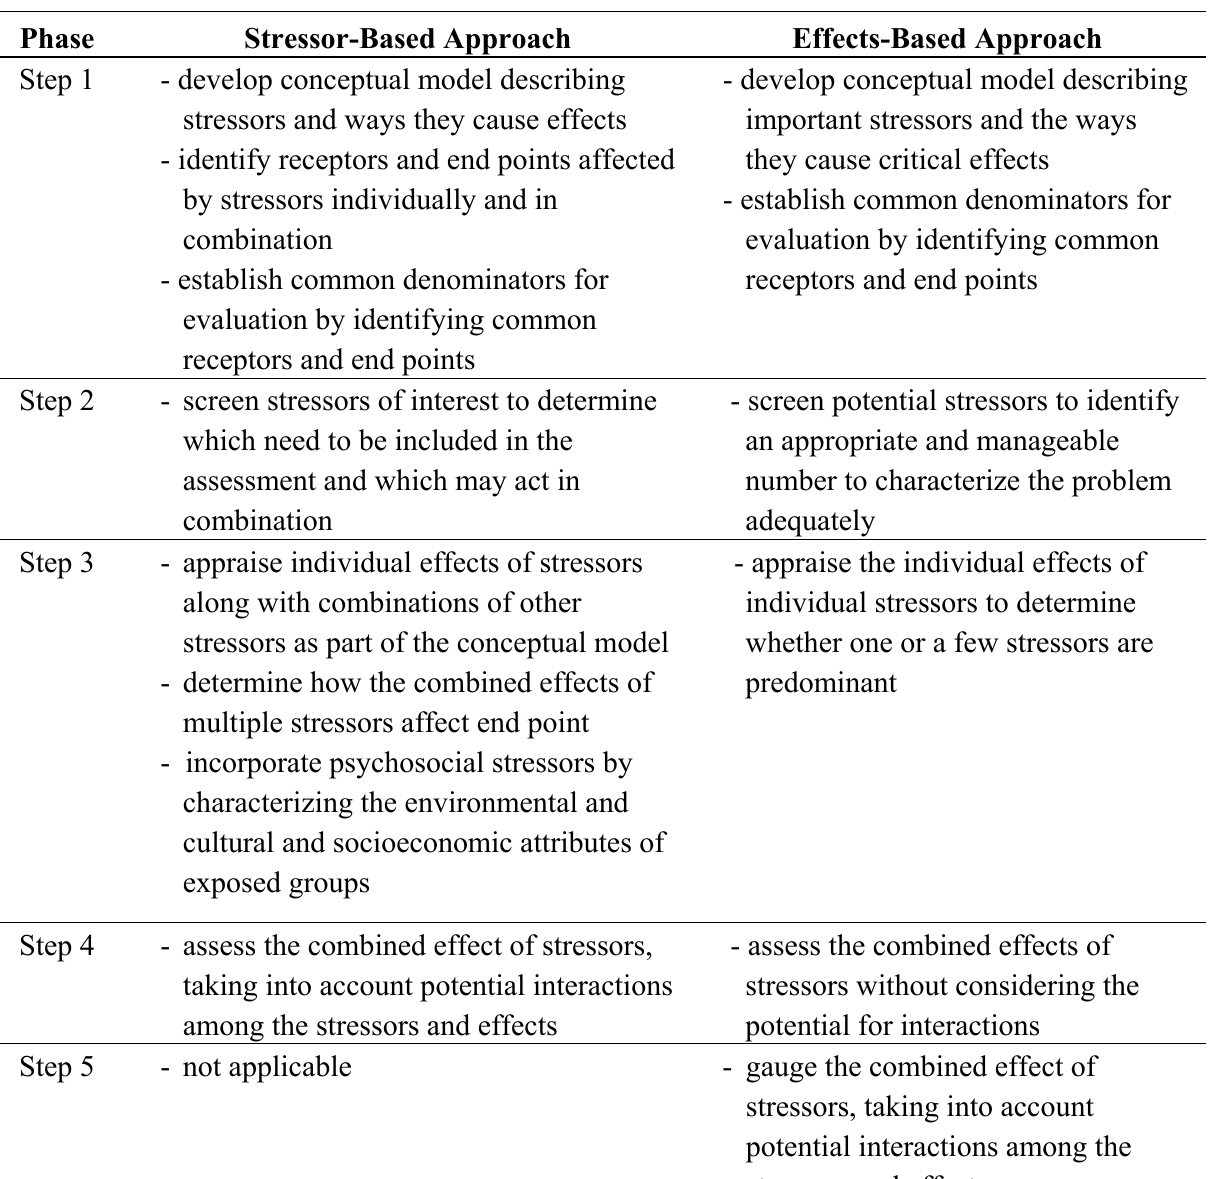
Table 5. Comparison of Phased Approaches for Stressor-Based and Effects-Based Cumulative Risk Assessment as described by Menzie et al .